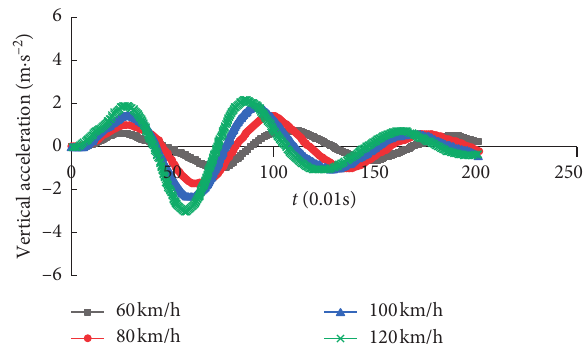
Figure 12: Vertical acceleration of testing vehicle at different speeds.